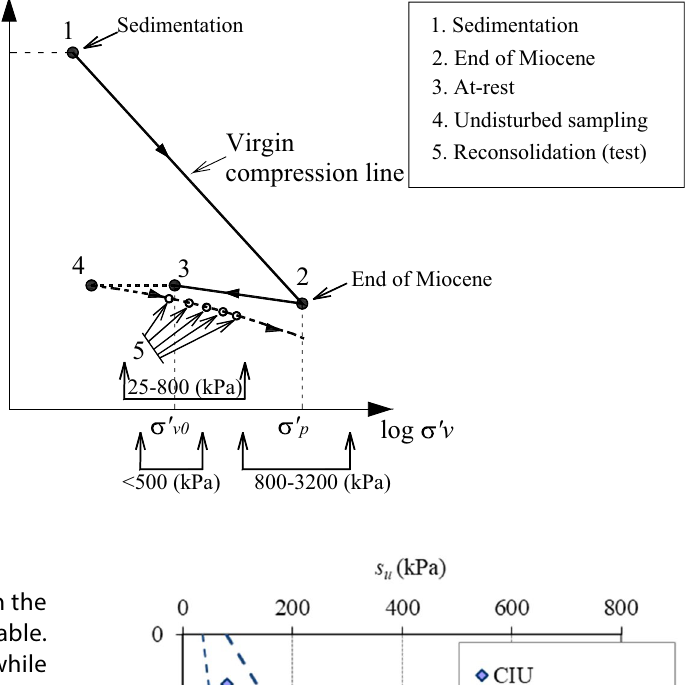
Fig. 6 e-log σ ′ diagram show‑ v ing stress state changes that occur on a sample prior to triaxial testing [6]